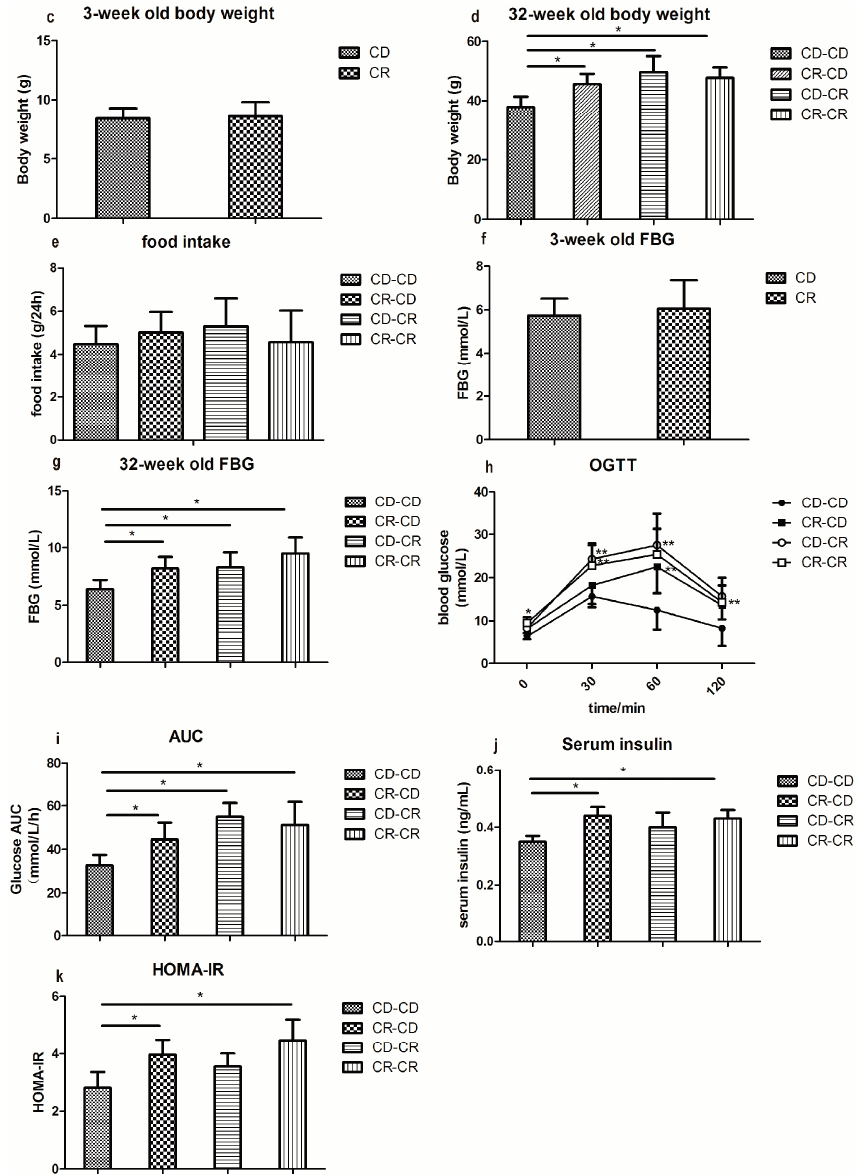
Figure 1. Serum chromium level ( a ) at week 32; body weight on birth day ( b ); week 3 ( c ); and week 32 ( d ); food intake ( e ); fasting blood glucose (FBG) at week 3 ( f ) and week 32 ( g ); and blood glucose in oral glucose tolerance test (OGTT) ( h ) and blood glucose area under the curve (AUC) ( i ) in OGTT, fasting insulin ( j ) and homeostasis model assessment of insulin resistance (HOMA-IR) ( k ) at week 32 in male offspring. CD, control diet; CR: chromium restriction. Each bar represents the mean ± SD. For ( a , d , e , g – j ), n = 8 per group; for ( b , c , f ), n = 16 per group. * p < 0.05, ** p < 0.01